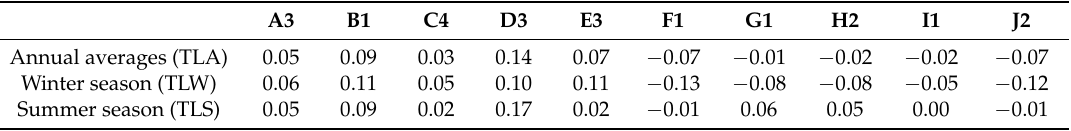
Table 3. Linear trend (m/s per decade), values of the average annual wind speed, computed for 10 reference points (one of each zone) considered as the most representative. Results corresponding to the 35-year time interval 1983–2017. TLA represents the trend line for the annual averages, while TLW and TLS are the trend lines for the winter and summer seasons,